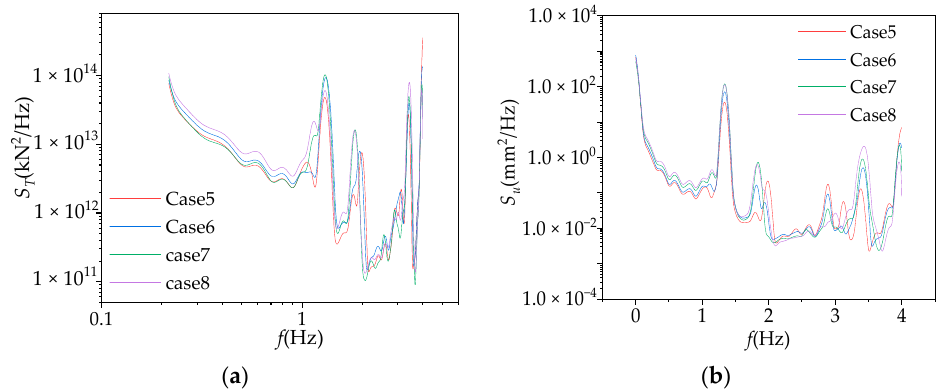
Figure 10. Response spectrum analysis of fractured cables in risk regions: ( a ) cable tension response spectrum and ( b ) bridge displacement response spectrum.